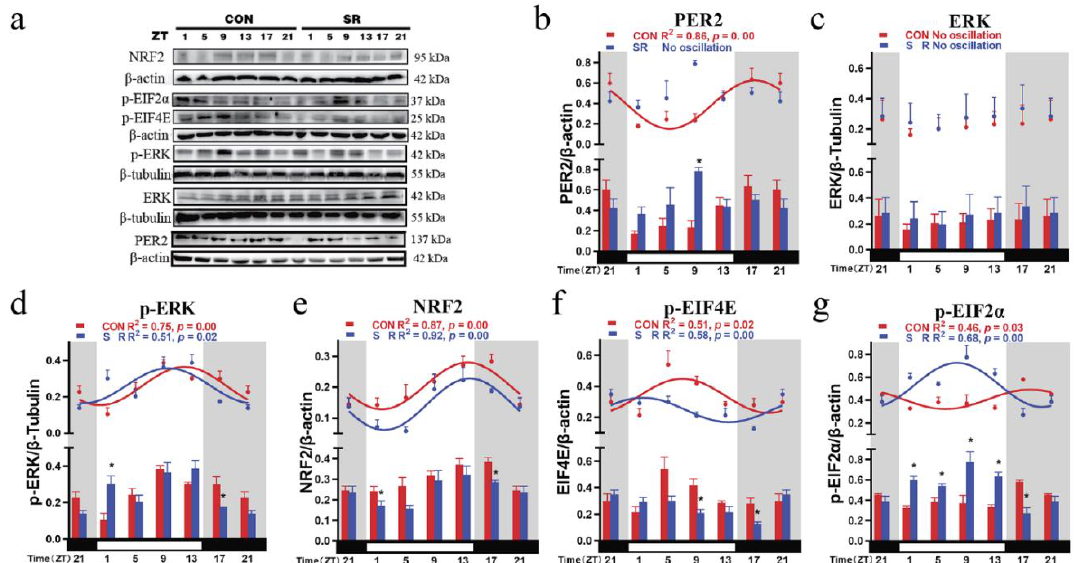
Figure 3. Temporal changes in the levels of proteins in the hypothalamus of mice. ( a ) PER2, ERK, p-ERK, NRF2, p-EIF4E, p-EIF2 α , β -actin, and β -tubulin protein production in the CON and SR groups was examined by Western blotting, and relative protein levels of NRF2, p-EIF4E, and p-EIF2 α were normalized to β -actin, while relative protein levels of ERK and p-ERK were normalized to β -tubulin. ( b – f ) The trend of PER2, ERK, p-ERK, NRF2, p-EIF4E, and p-EIF2 α over time and the comparison at a specific point in time. The horizontal white bar on each figure represents the subjective daytime, and the black bar represents the subjective night; n = 3 mice per time point. Quantitative analysis of the data is shown as the mean ± SEM. The curve indicates the best fit to the points by cosinor analysis. R 2 values represent the degree of fitting. *: p -values indicate the significance of regression analysis, with significance defined as p < 0.05. The comparison at each time point uses t